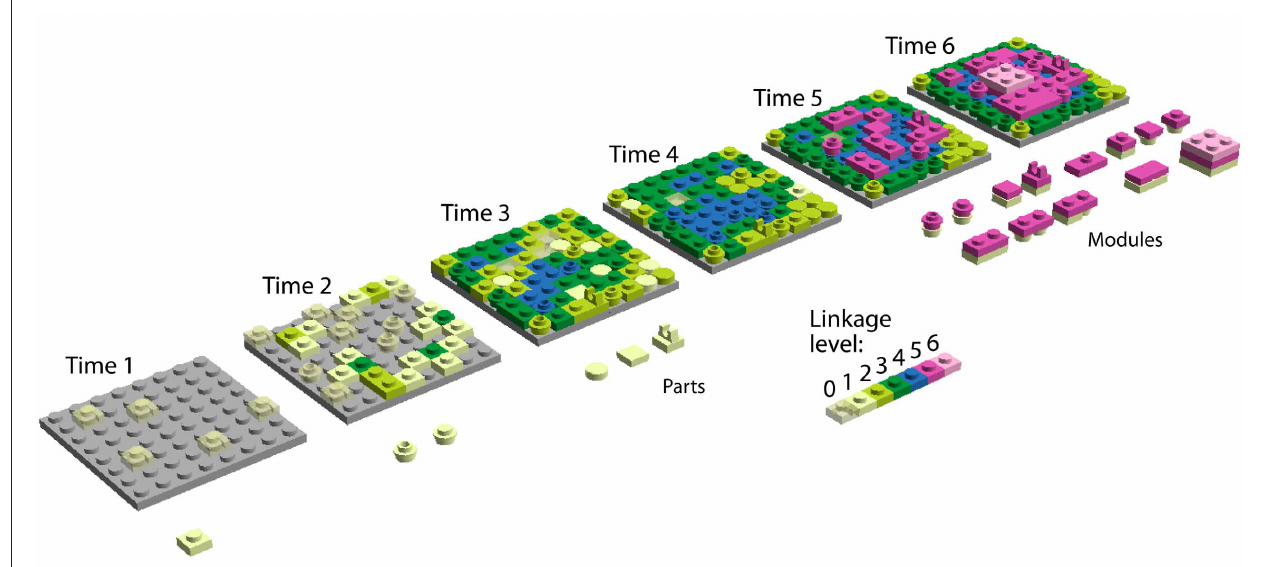
FIGURE 1 | A linkage model of emergence of modules. We illustrate our main hypothesis—diversification and integration of parts unify parts into modules, which then diversify—with the evolution of a system of Lego ® blocks. The blocks represent aspects of hierarchical levels of organization in the system. Stud-hole interactions of neighboring blocks and interactions of blocks with walls should in reality be portrayed as multidimensional. Biologically, levels 1, 2, 3, and 4 could represent (for example) levels of organization within proteins—spaces of protein sequences, structures, domains, and quaternary structures, respectively. These levels can be seen as multidimensional spaces in which parts diffuse as they change. We show only three levels as these evolve, with each level materializing in two dimensions—a layer—for the sake of simplicity. Blocks interact only with neighbors and attempt to maximally occupy a space defined by their functionality. Hierarchical level 1 (grey base plate) is a previous space that we will not describe. Hierarchical level 2 develops an increasing repertoire of parts (blocks of different shape in shades of green and blue) and an increasing number of interactions per part (linkage). This increases the connectivity and diversity of parts, with sides of the blocks in contact with others representing extents of linkage 0, 1, 2, 3, and 4. Linkage increases with interactions among blocks; color hues of blocks represent extent of linkage. Hierarchical levels 3 and 4 are only accessible to blocks when linkage